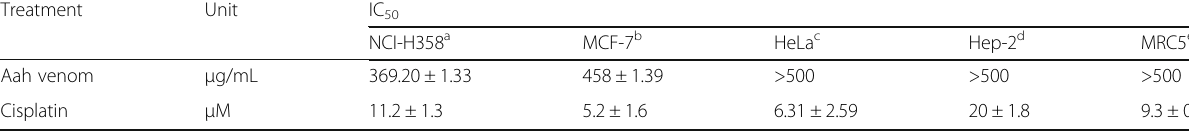
Table 1 IC 50 values of Aah venom and cisplatin in panel of cell lines NCI-H358, MCF7, HeLa, Hep-2, and MRC5 Treatment